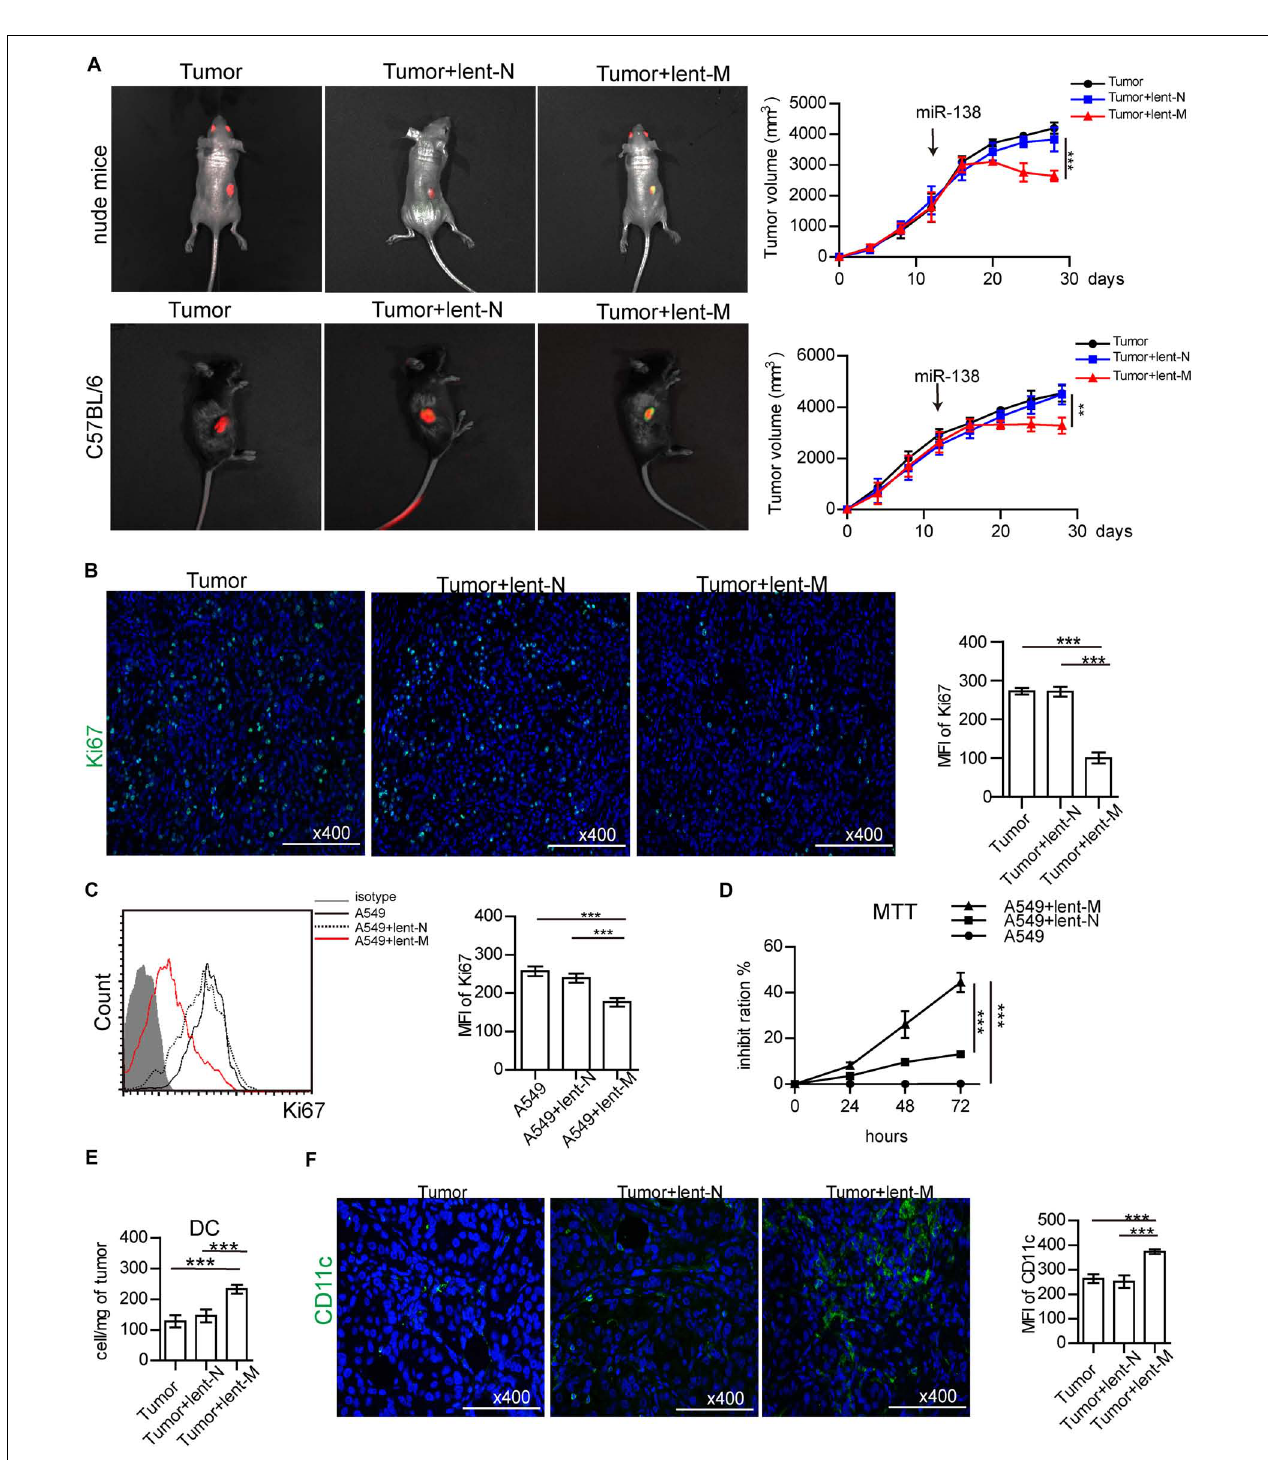
FIGURE 1 | MiR-138 treatment decreases the proliferation of lung tumor cells. (A) lent-NC (lent-N, green)/lent-miR-138 (lent-M, green) were administered to nude (left upper panel) or C57BL/6 mice (left bottom panel) bearing corresponding tumor cells (red). After Lent-M treatment, the mean of tumor volume was measured and analyzed (right panel). (B) The expression of Ki67 (green) in tumor tissues from lent-M/lent-N treated A549 tumor bearing mice or non-treated animals. ( A,B , eight mice per group were assessed; *** P < 0.001). (C) Flow cytometry detection Ki67 expression on A549 cells, with or without lent-M/lent-N treatment. (D) With, lent-M or lent-N treatment or not, the inhibit ratio of the proliferation of A549 cells were measured by MTT. (E) The amounts of DCs were elevated in tumors from lent-M treated mice compared with the lent-N-treated and untreated groups. (F) Immunofluorescence was used to detect CD11c + cells (green) in tumor tissues from mice treated with lent-M and lent-N, respectively, as well as from untreated animals. The nucleus is blue, Bar = 100 µ m. ( C–F , three independent assays were performed; *** P < 0.001).